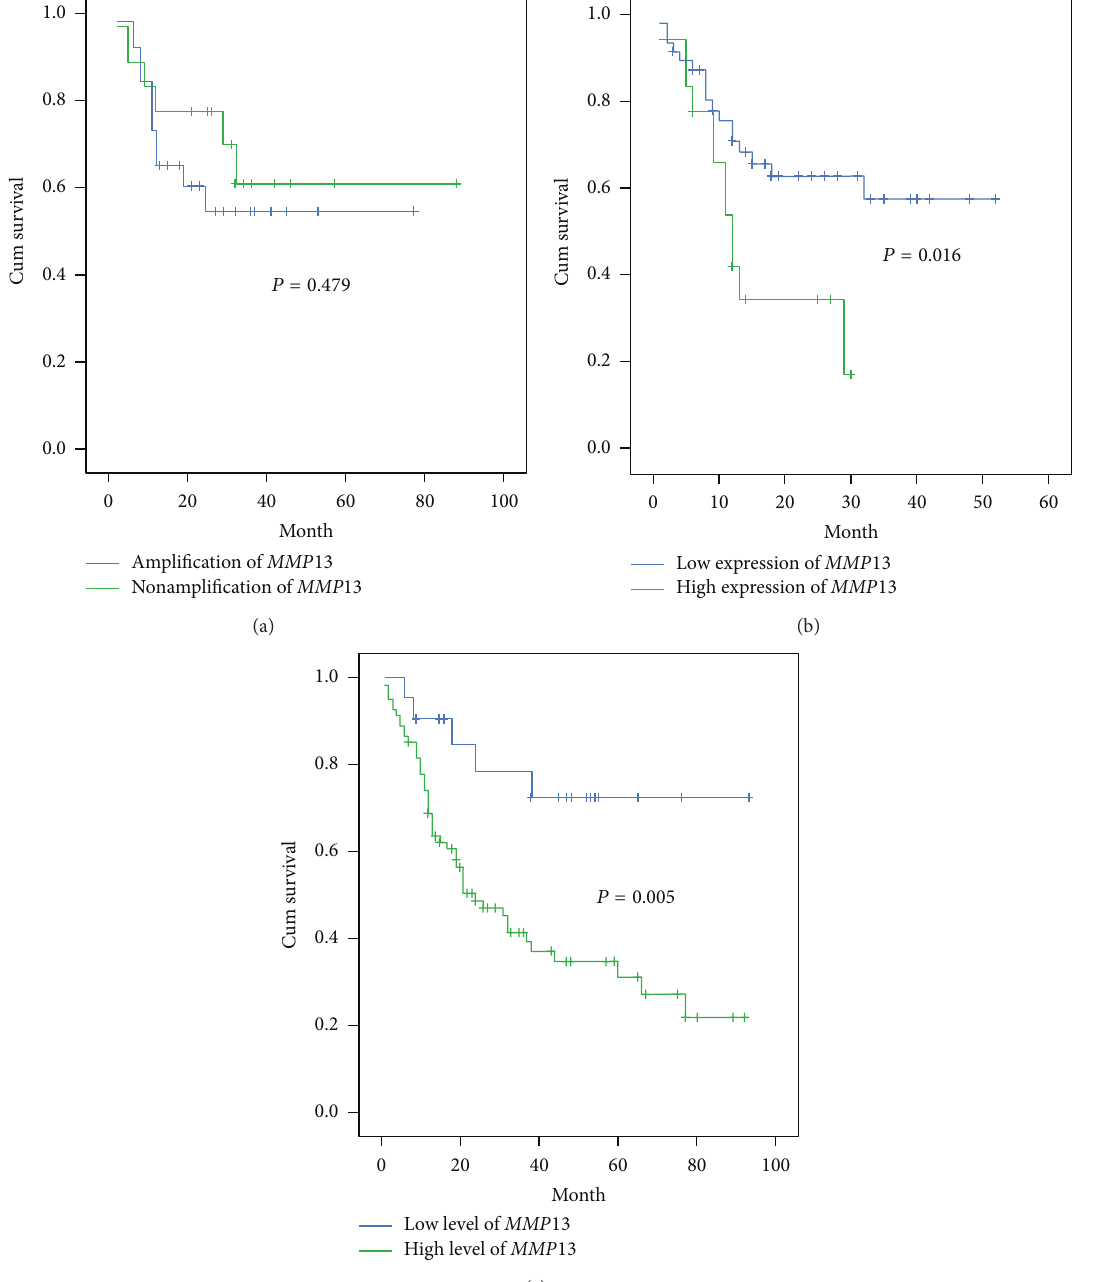
Figure 5: Overall survival curves were analyzed according to MMP13 copy number (a), mRNA expression (b), and protein expression (c) using Kaplan-Meier estimate with log rank